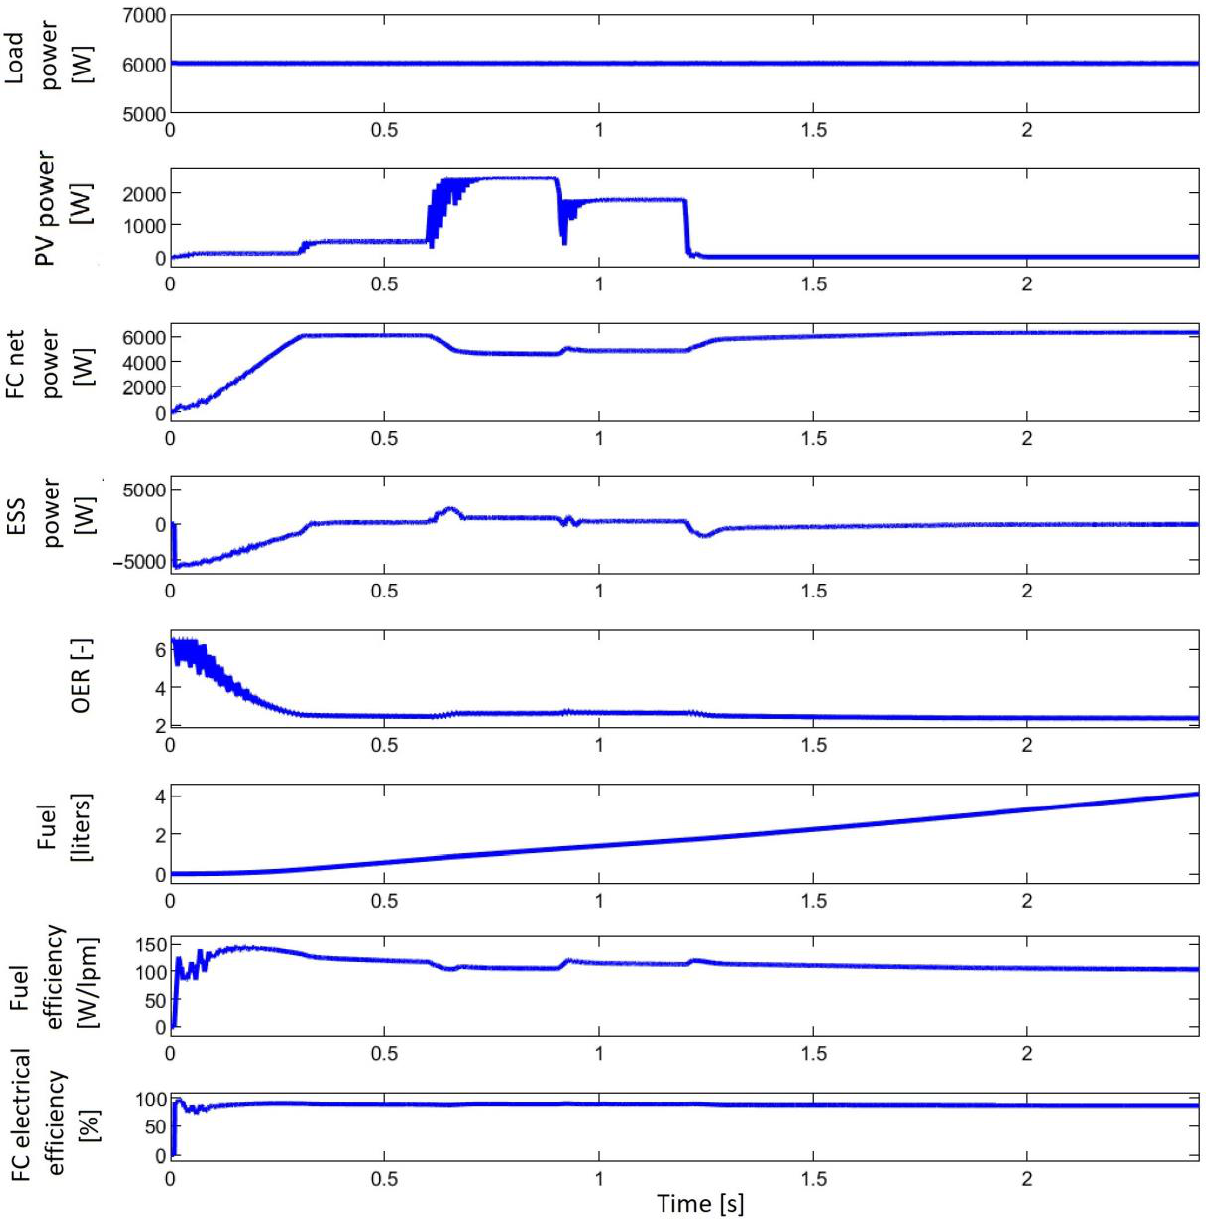
Figure 15. The behavior of the PV/FC/ESS system using strategy S2 in the scenario SC6. The FC system operates safely (with OER higher than 2) and efficiently (see plot 5, and plots 7 and 8 in Figure 15, respectively). The total fuel consumption (see plot 6 in Figure 15) will be 4.23 L, 4.093 L and 4.026 L for strategies S0, S1 and S2. Therefore, the fuel economy for strategy S2 compared to strategy S1 is of 0.067 L, which means 1.6750